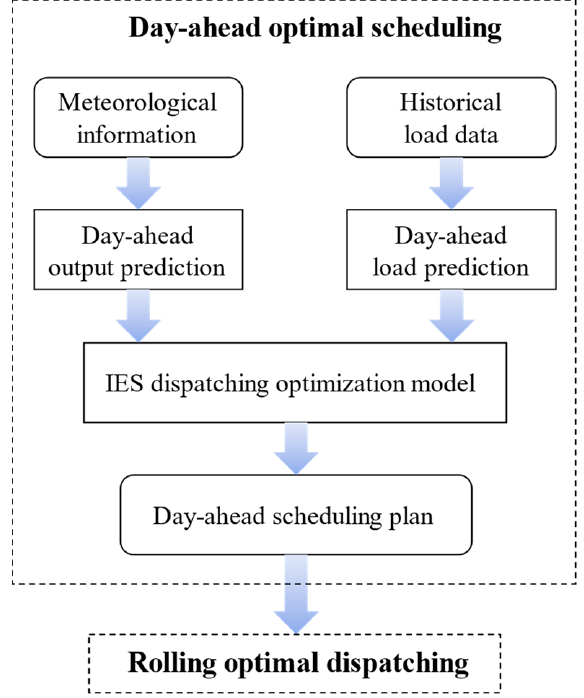
Figure 3. Illustration of day-ahead optimal scheduling.